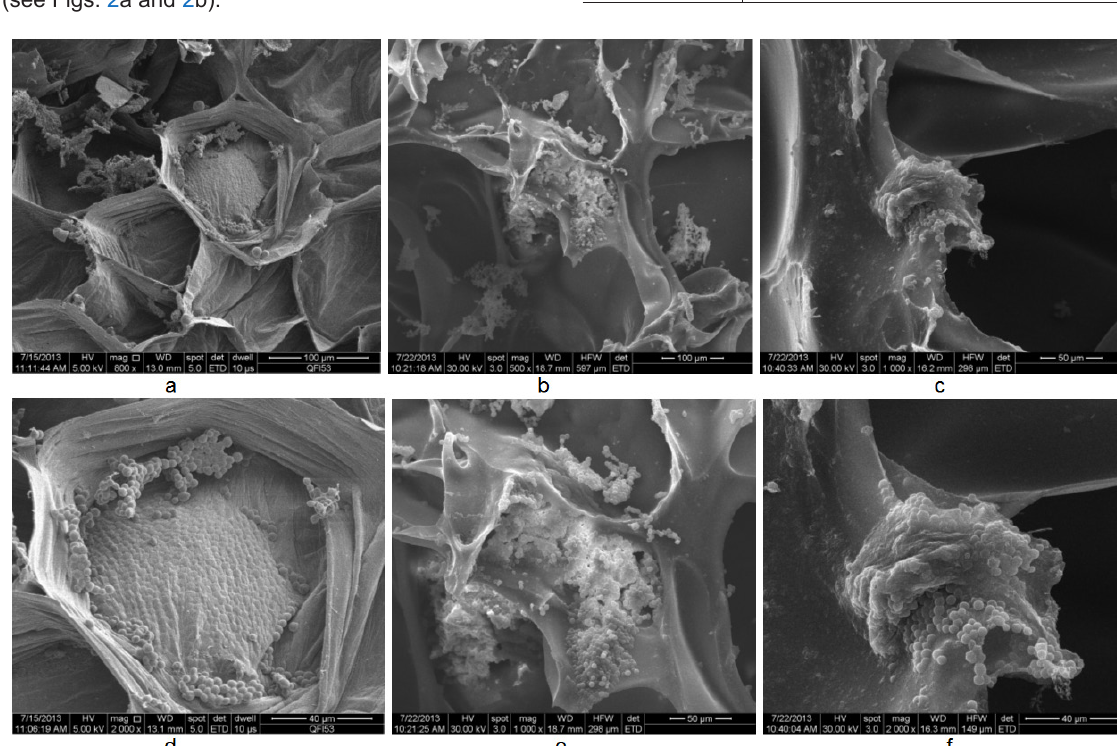
Figure 1. SEM surface images for structures on which the yeast developed for 3 days: a) MSS; b) HEMA-PAAm; c)